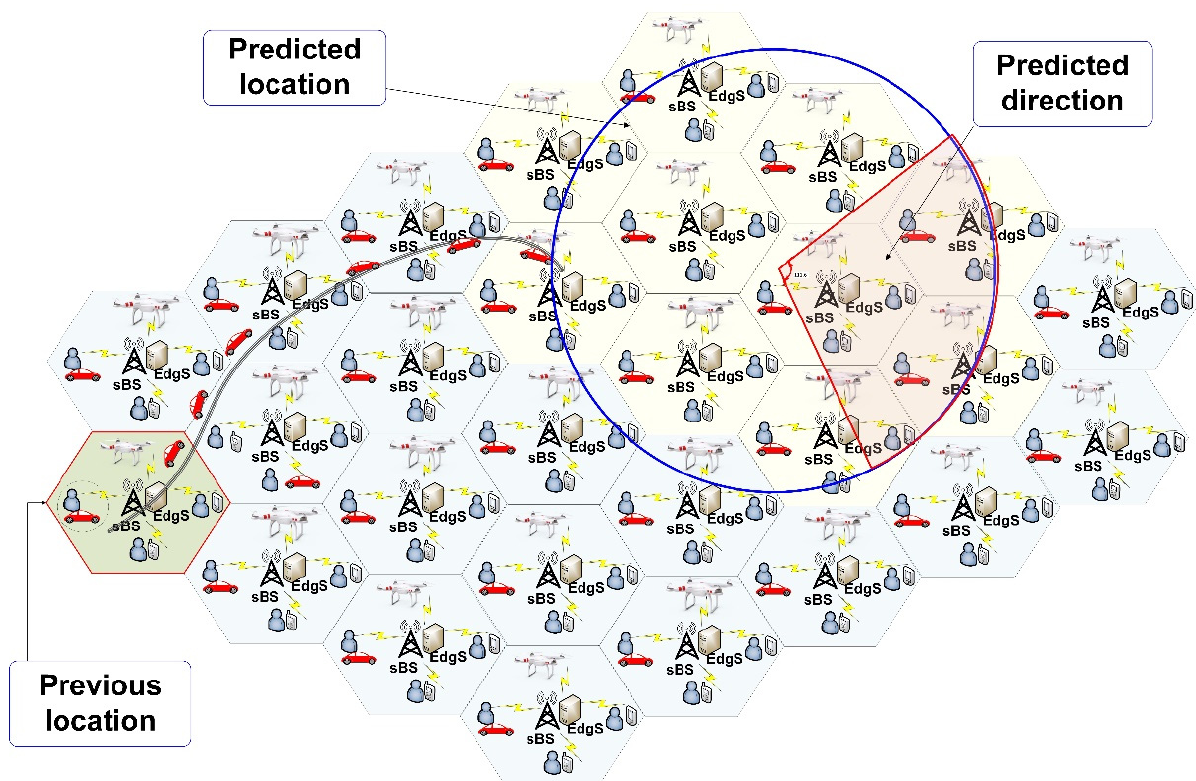
Figure 2. Mobility and location prediction use case.